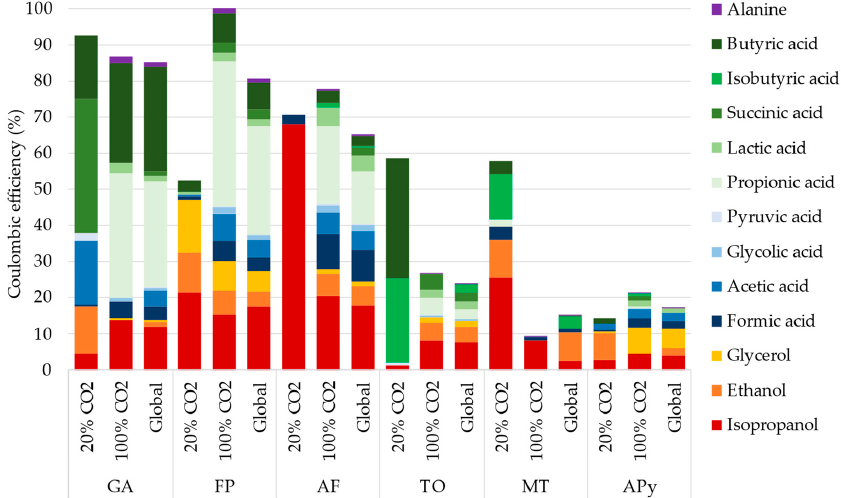
Figure 4. Coulombic efficiency of the organic production during the 33 days of experiment with the 6 selected strains. The cumulative bar plots represent the coulombic efficiency during the 13 days with 20% CO 2 in the gas sparging, during the 20 days with 100% CO 2 in the gas sparging, and the global coulombic efficiency during the whole experiment.